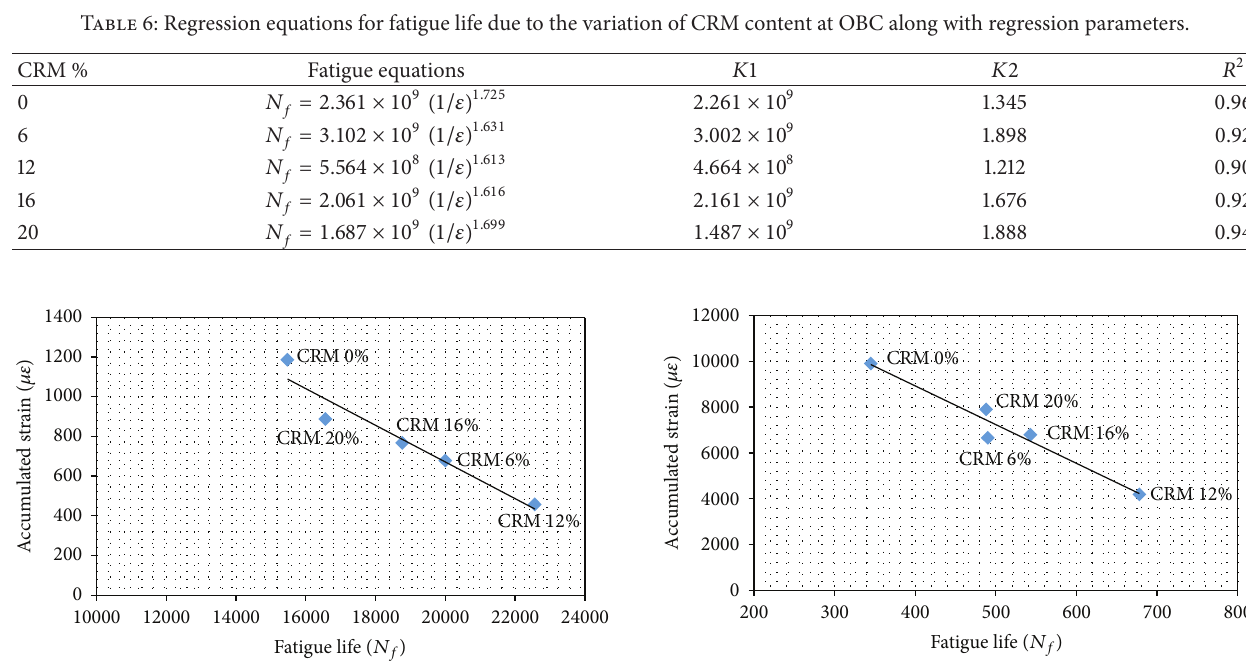
Figure 4: Fatigue life versus strain at 2000 N stress.